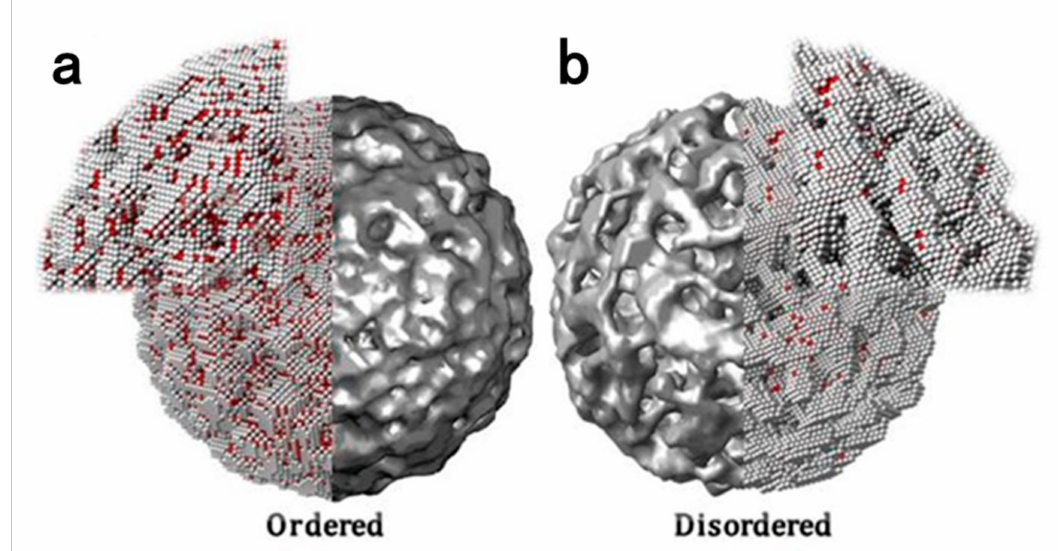
Figure 4. Disordered and ordered particles after acidic treatment: simulated ordered particle at the tipping point of pore creation ( a ) and disordered particle with developed porosity ( b ), taken at the same time [14]. Copyright 2016 American Chemical